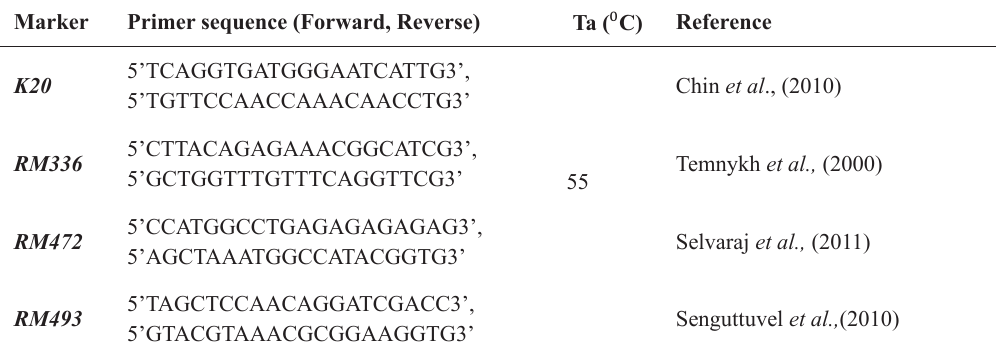
Table 1: The markers used for PCR-based DNA fingerprinting. Marker Primer sequence (Forward, Reverse)